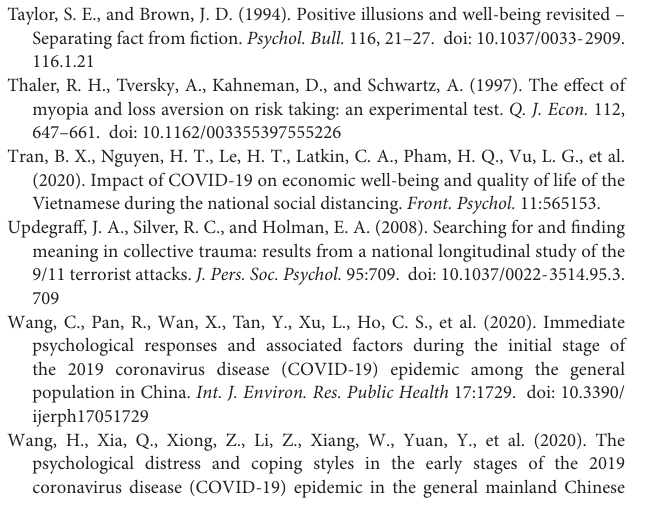
population: a web based survey. PLoS One 15:e0233410. doi: 10.1371/journal. pone.0233410 Weakliem, D. L., and Frenkel, S. J. (2006). Morale and workplace performance. Work Occup. 33, 335–361. doi: 10.1177/0730888406290054 Conflict of Interest: The authors declare that the research was conducted in the absence of any commercial or financial relationships that could be construed as a potential conflict of